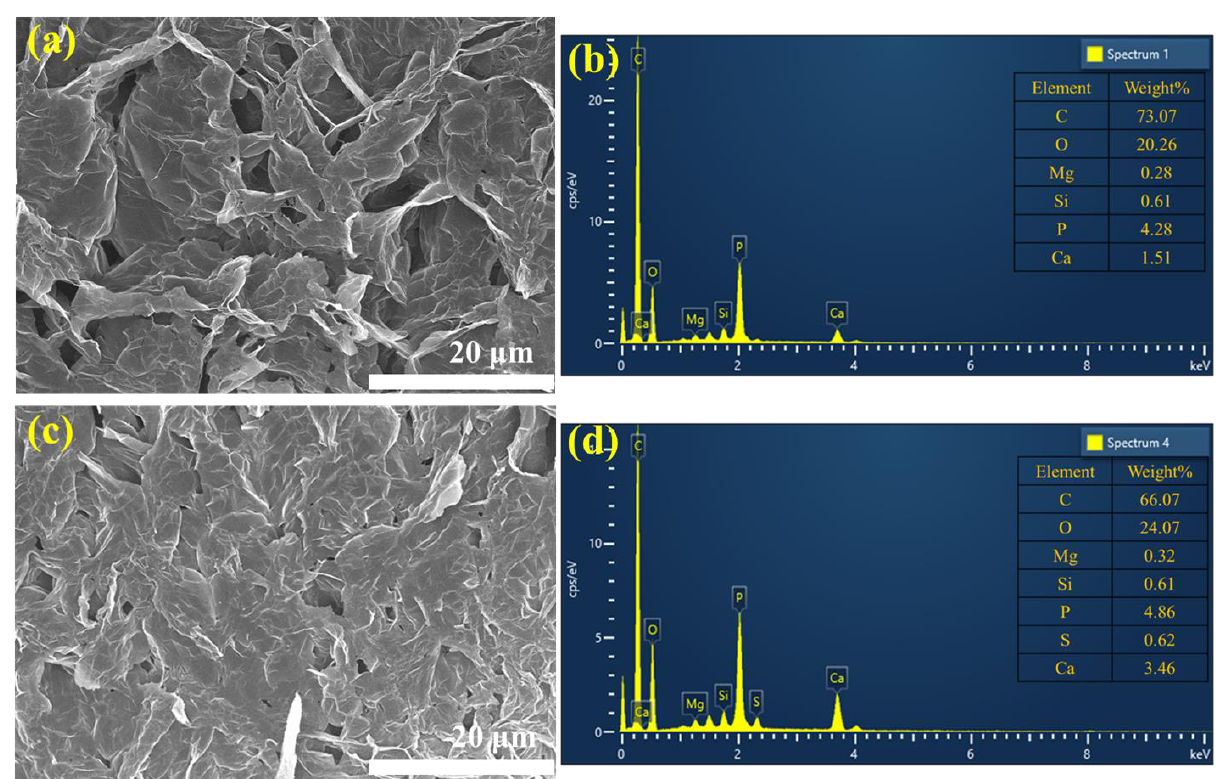
Figure 5. The SEM images ( a , c ) and corresponding EDS spectra ( b , d ) of the char residue on the EPS/HFR0 ( a , b ) and the EPS/HFR12 ( c , d ).